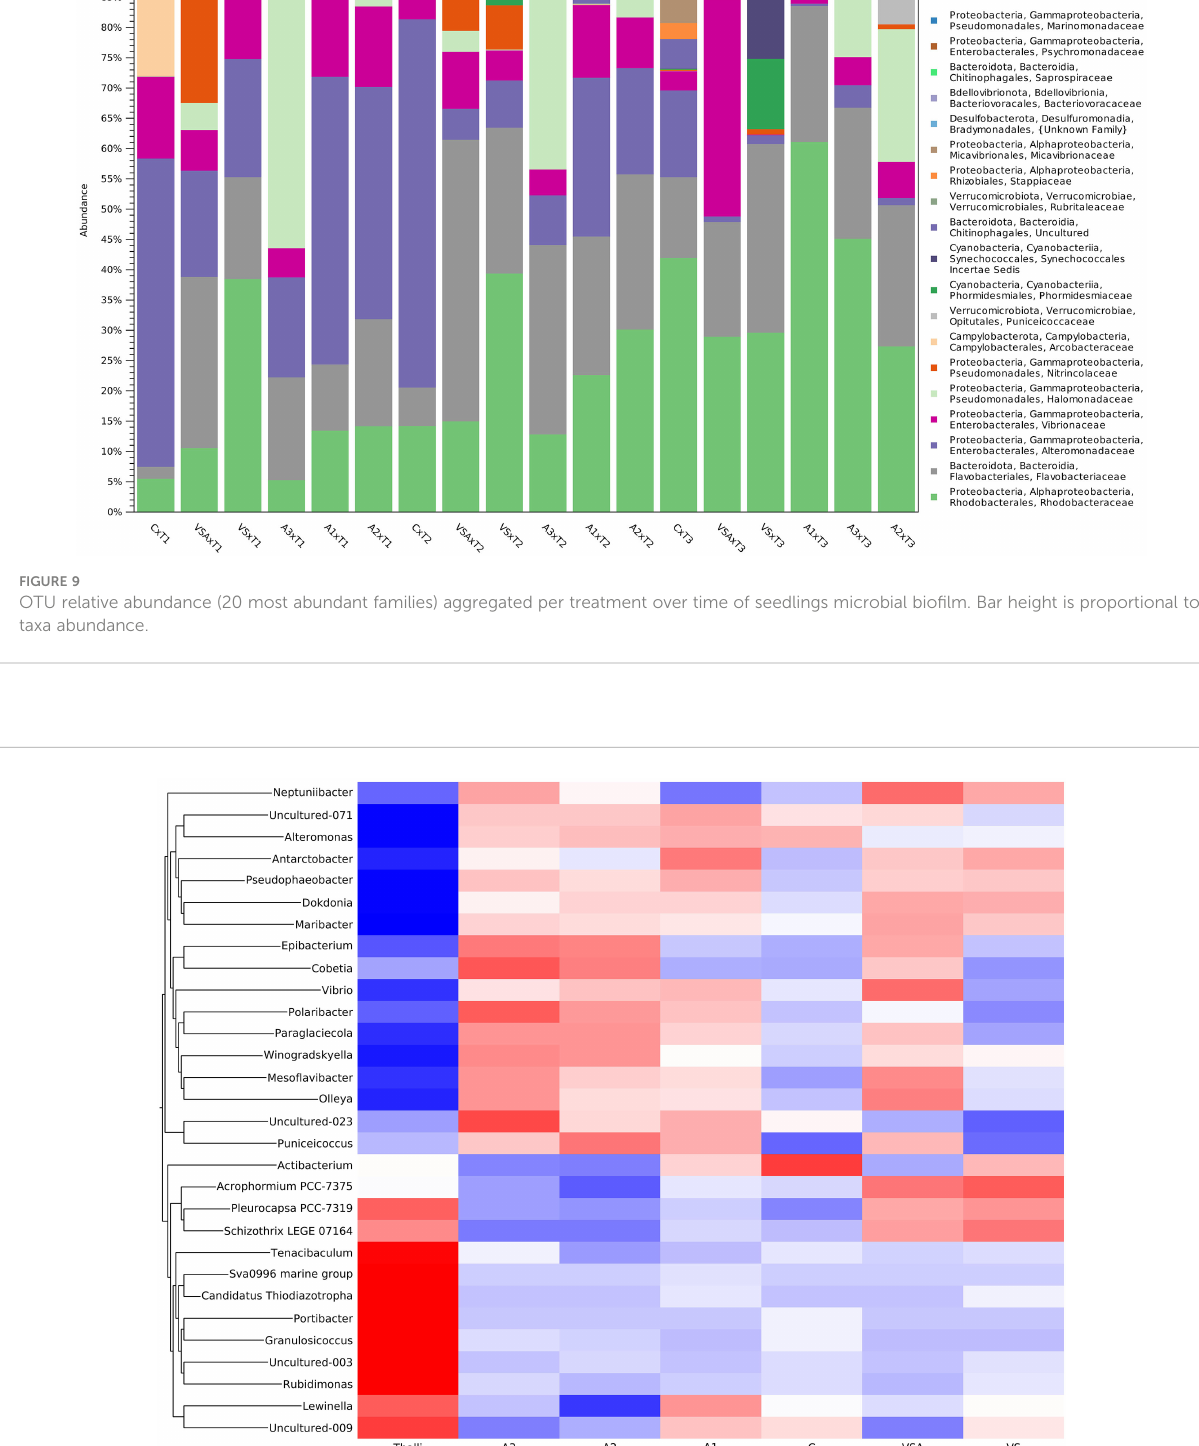
FIGURE 10 Heat-map of OTU relative abundance in the adult thalli and the seedlings community. Z score bar indicates enrichment (red) or depletion (blue) factor in comparison to the mean OTU value.